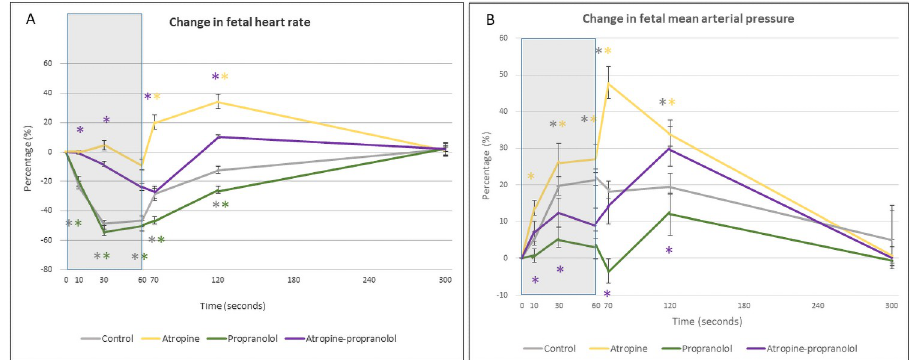
Fig 1. Change in fetal hemodynamics during and after cord occlusion. Change in fetal heart rate (A) and fetal mean arterial pressure (B) in treated fetuses exposed to three applications of 1-minute umbilical cord occlusion (grey zone) every 5 minutes. Data are expressed as mean ± standard error. � p < 0.05 vs.